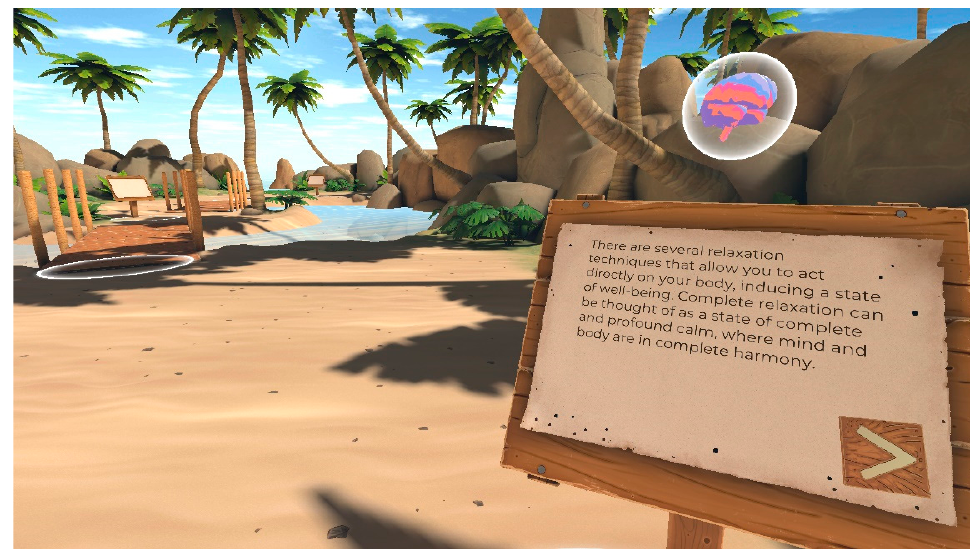
Figure 2. Along the three paths of MIND-VR, users are given information on stress and anxiety via text and audio.